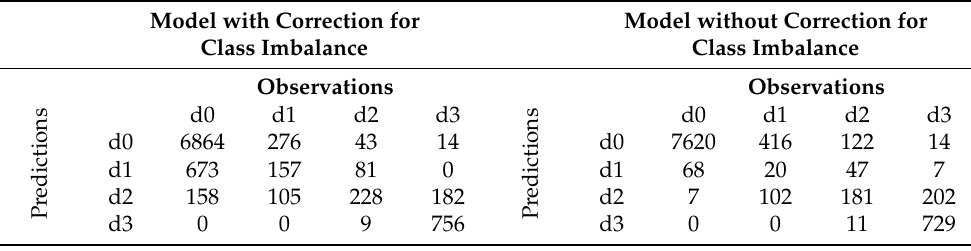
Table 2. Observations vs. predictions of the full models (with and without correction for class imbalance) on the pot images of the testing datasets. On the left, observations and associated predictions produced by the full model accounting for class imbalance. On the right, observations and predictions produced by the full model not accounting for class